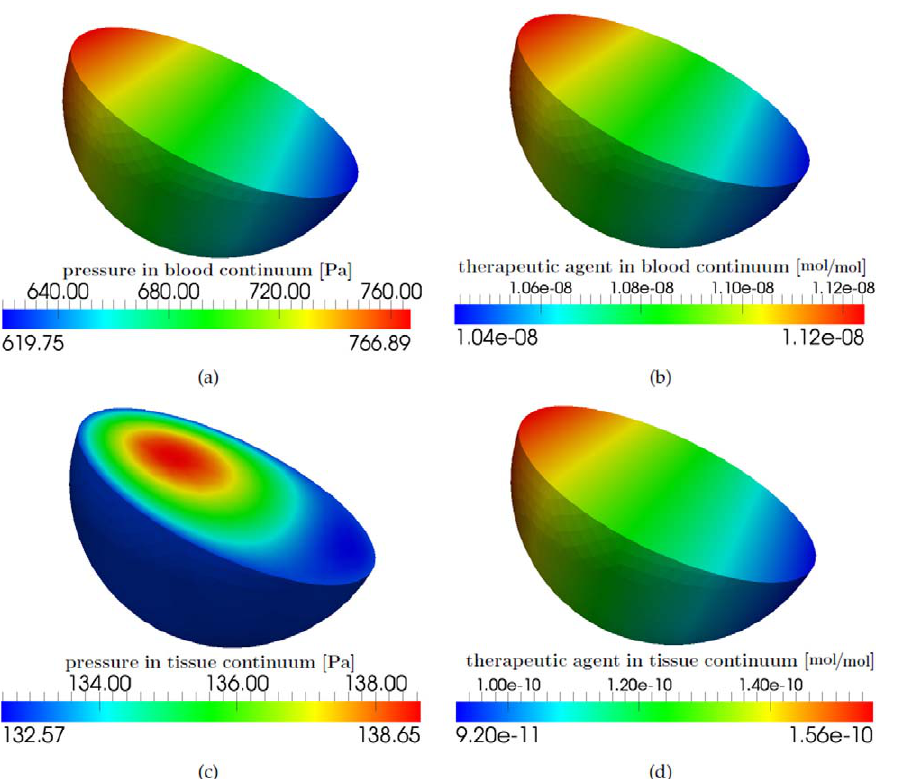
Figure 14. Results for a tumor alveolus (middle blue rectangle in Figure 10), at the final time step of the simulation. (a) Pressure distribution within the pulmonary capillary bed continuum [Pa]. (b) Drug distribution [ mol = mol ] within the pulmonary capillary bed continuum. (c) Pressure distribution within the pulmonary tissue continuum [Pa]. (d) Drug distribution [ mol = mol ] within the pulmonary tissue continuum.